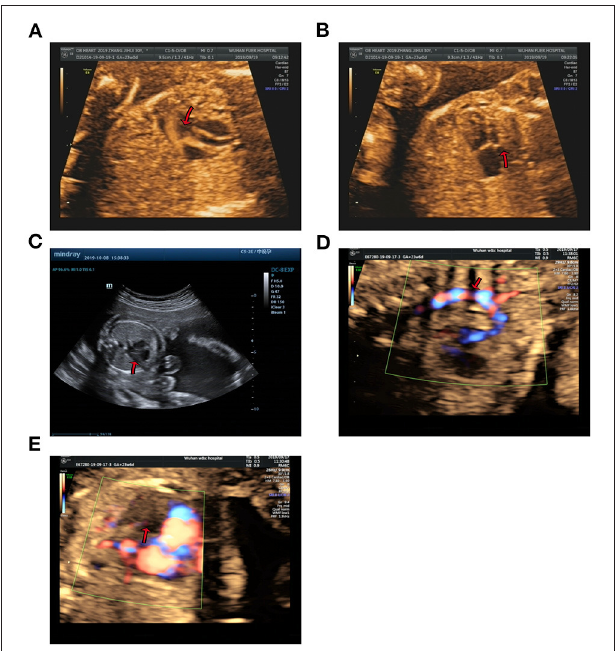
FIGURE 2 | Echocardiographic images of fetal heart structures. (A,B) show fetal ventricular septal defect and hypoplasia of left heart in case 1. (C) displays a smaller left heart in case 2. (D,E) show coarctation of the aorta and mitral atresia in the fetal heart of case 3.